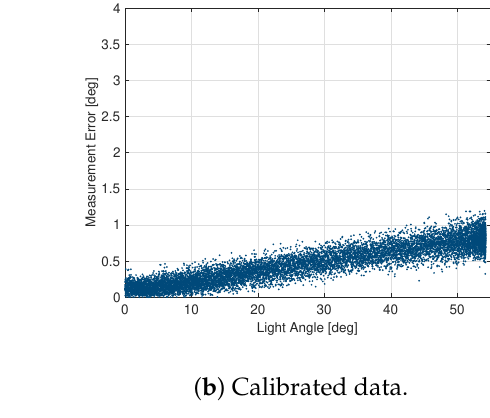
Figure 8. Light measurements with the FSS. Table 4. Fine sun sensor